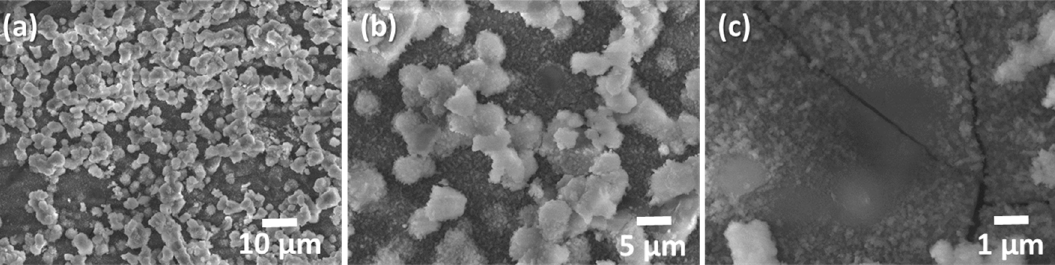
Figure 6. SEM images of the surface of sample REF. ( a ) 10 µ m; ( b ) 5 µ m; ( c ) 1 µ